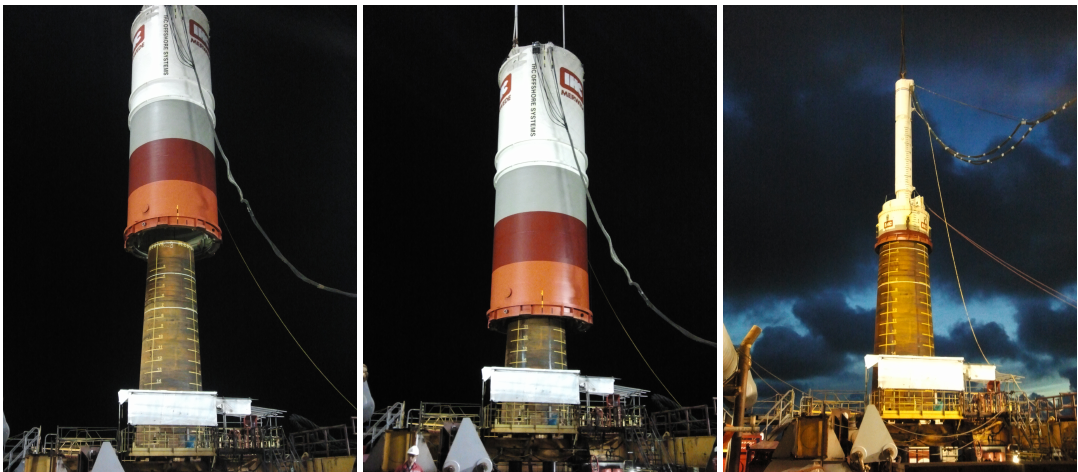
Figure 15. The installation of a 6.5 m pile with the use of a Noise Mitigation Screen (IHC Offshore Systems) at the German offshore wind farm Riffgat in the North Sea. In the left and middle pictures, the NMS is positioned by the crane around the monopile. In the right picture, the hydraulic hammer is positioned at the head of the pile and the NMS is invisible (positioned lower than the deck of the installation vessel). Source: Author’s personal archive from the Riffgat Offshore Wind Farm